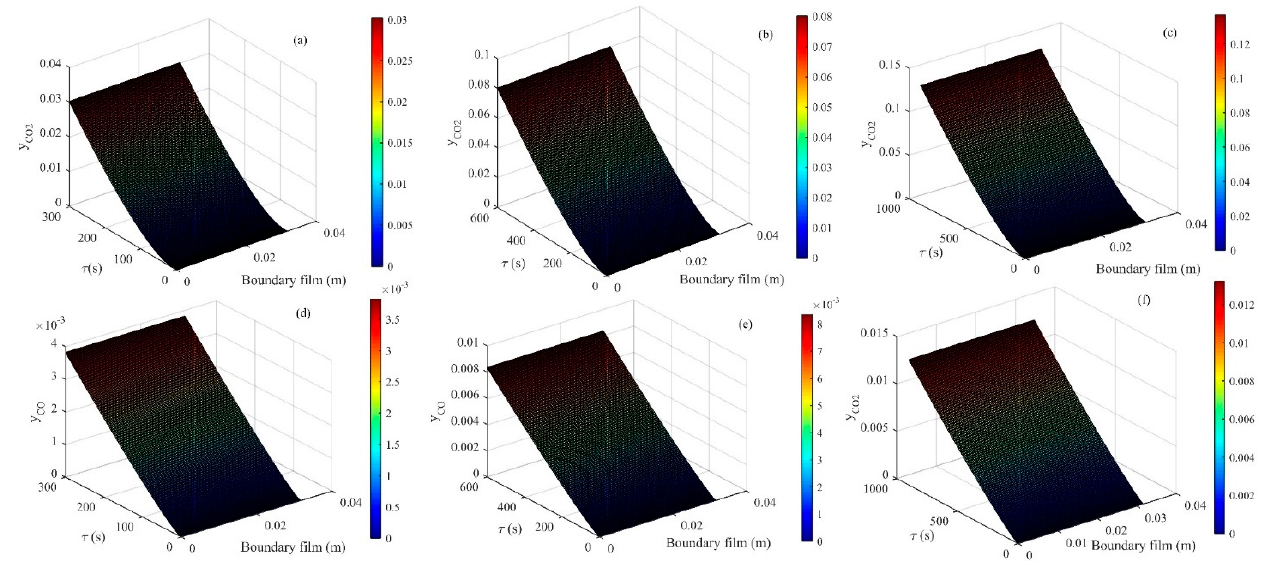
Figure 12. The distribution of mass fraction across the gas film (quasi-static condition) at different torrefaction duration ( a )